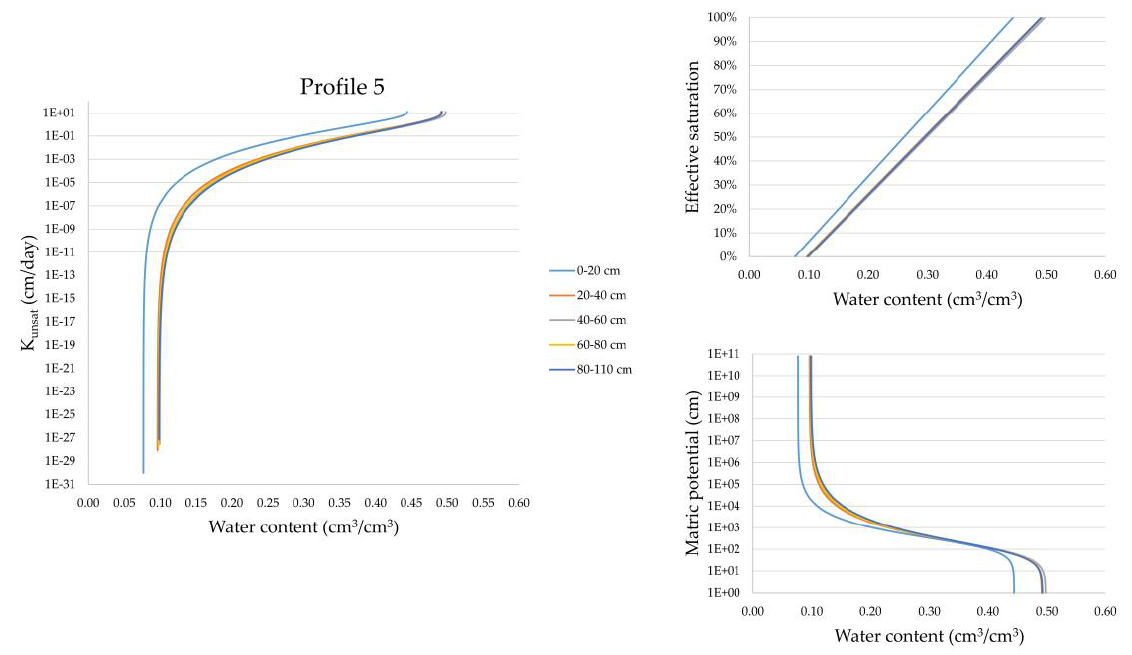
Figure 6. SWRCs, effective saturations, and unsaturated hydraulic conductivities in soil profile 4.